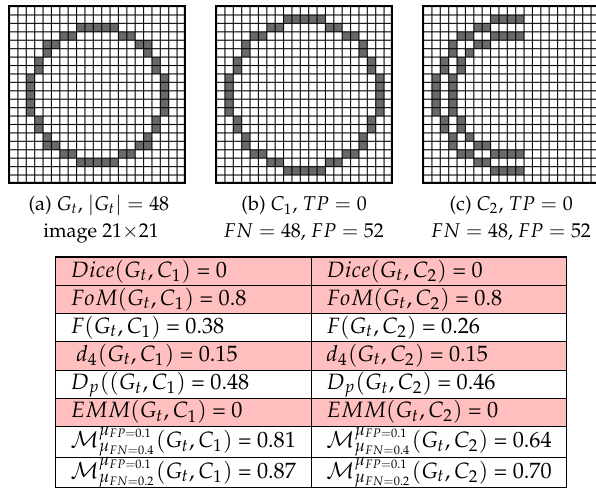
Figure 2. Different D c : FPs and number of FNs are the same for C 1 and for C 2 ( FN = 48, FP = 52), but the distances of FNs and the shapes of the two D c are